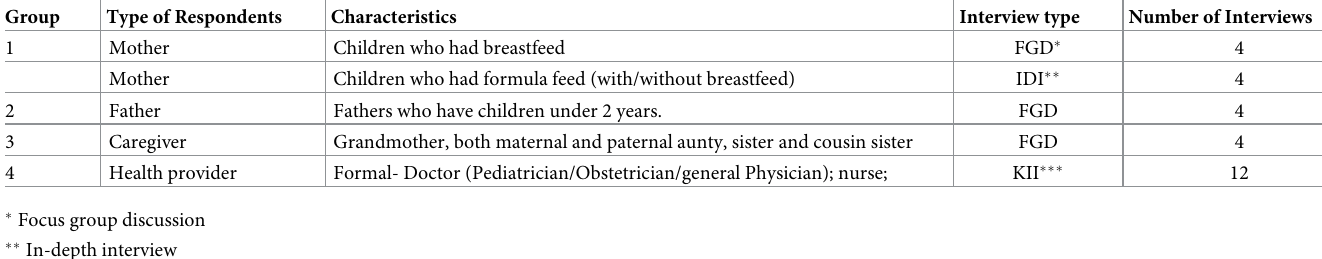
Table 1. Types of interviews by respondent